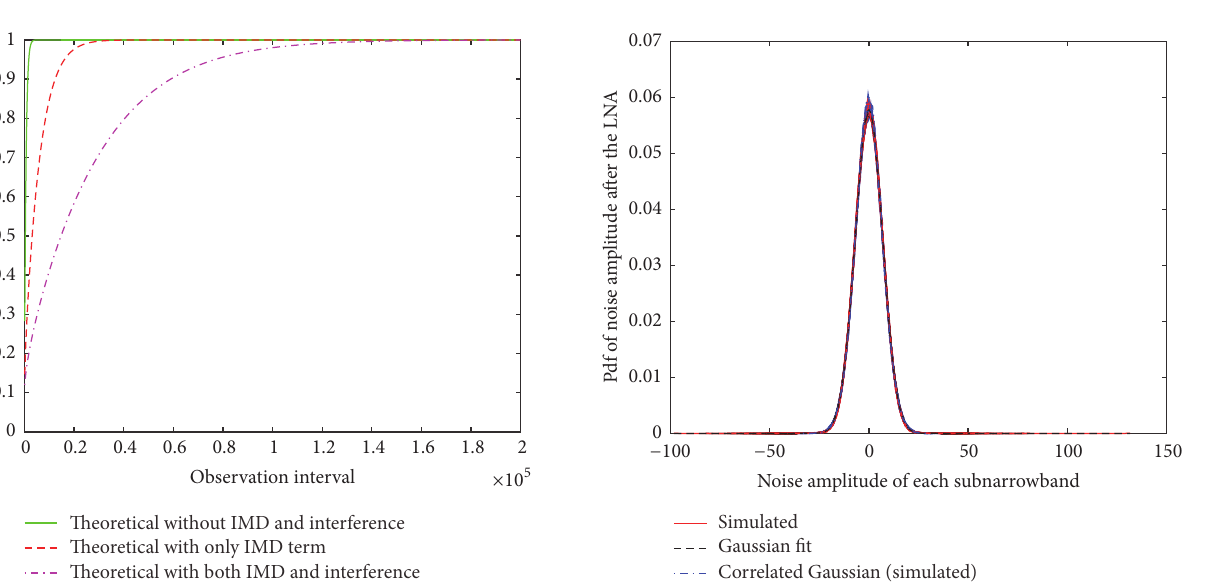
Figure 13: Observation interval versus 𝑃 𝑑 at 𝑃 fa = 0.1 . Figure 14: Pdf of the noise amplitude after nonlinear LNA.